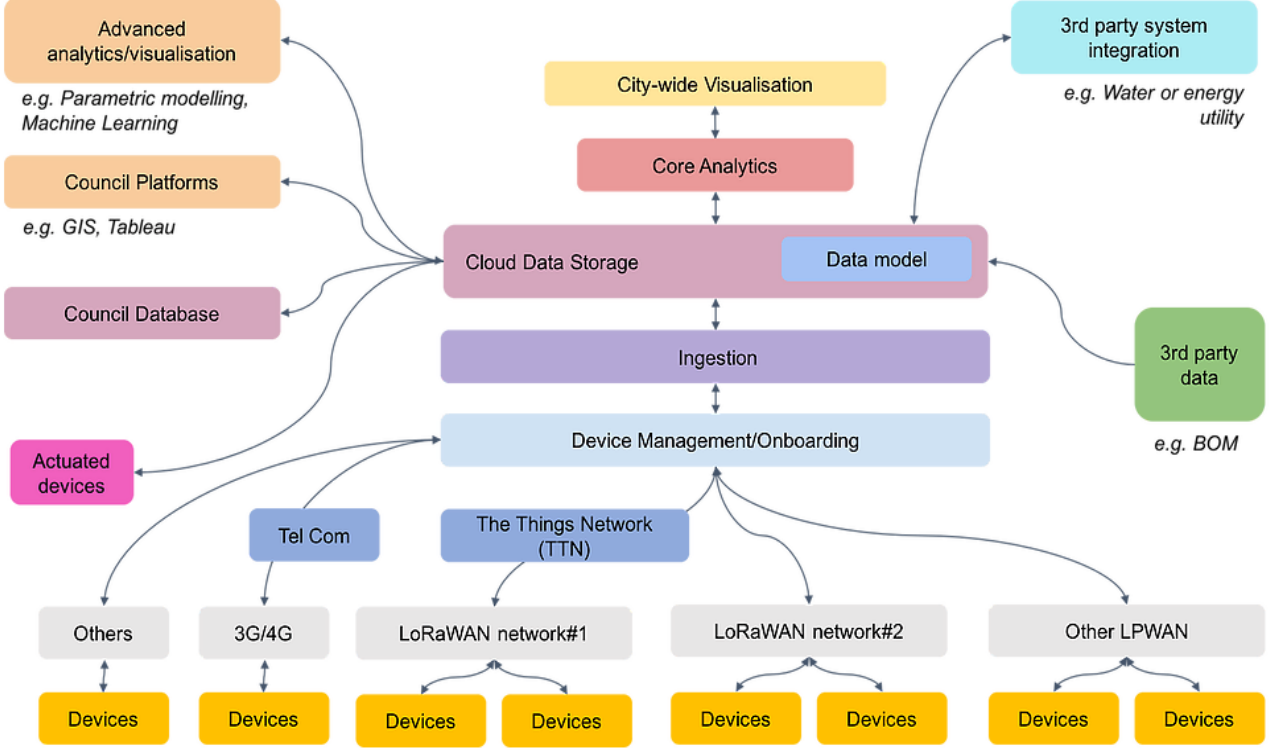
Figure 4. The overall architecture of the ROSE architecture (with the kind permission from the IoT Australia).